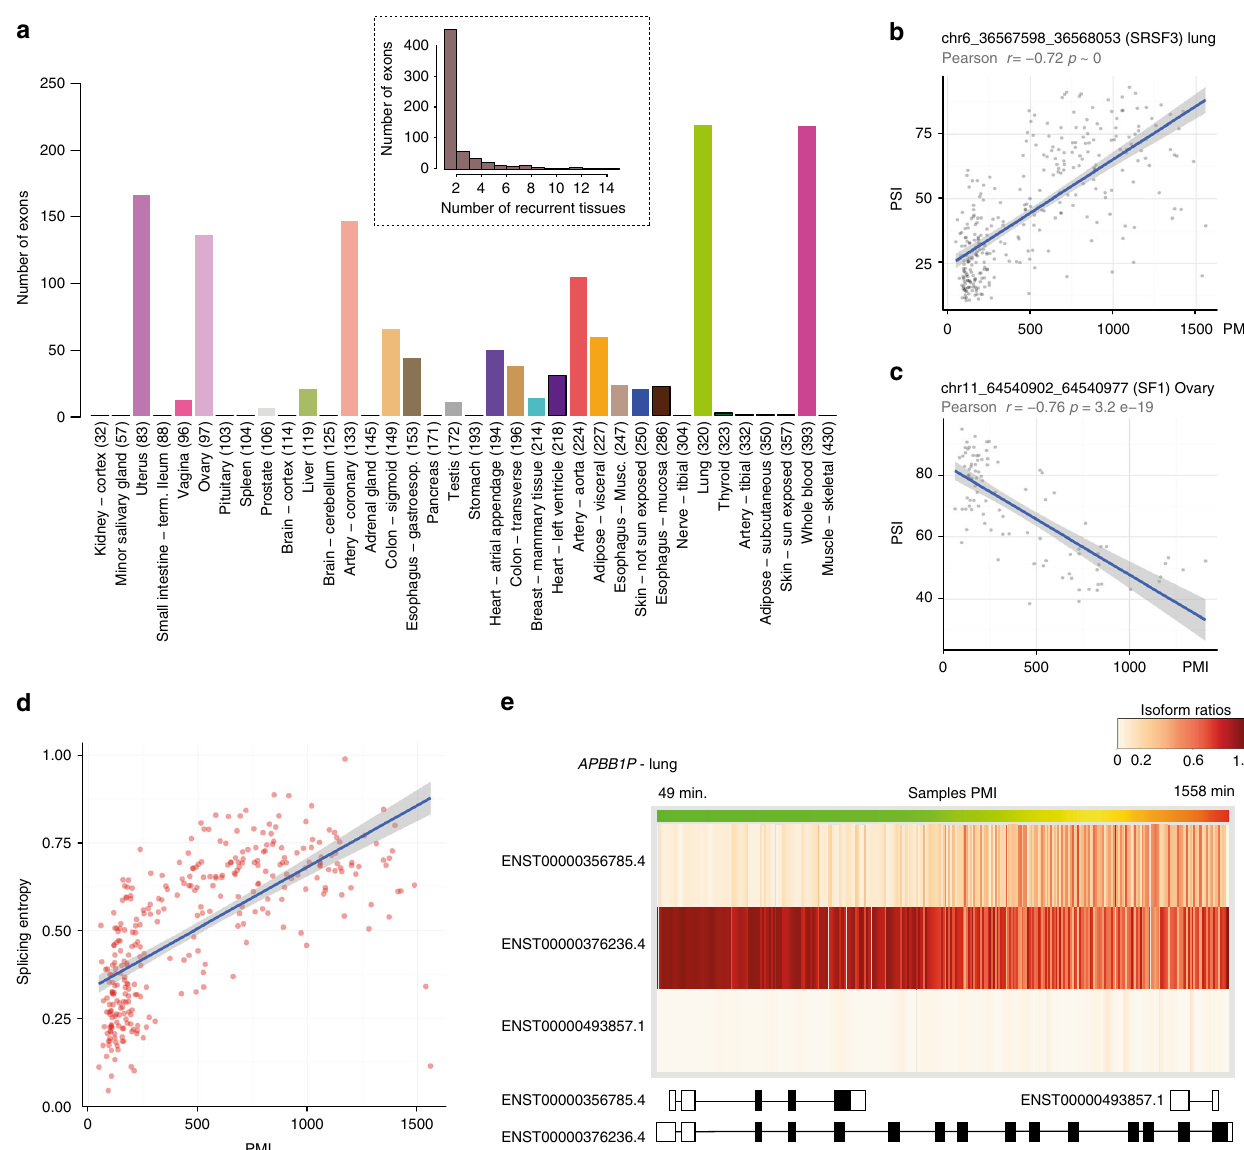
Fig. 5 Effect of PMI on splicing. a Distribution of the number of exons with signi fi cant differential inclusion across the different tissues; inset: number of exons with differential inclusion occurring in multiple tissues. b , c Examples of two exons with PMI-correlated inclusion levels. SRSF3 and SF1 encode pre- mRNA splicing factors that form part of the spliceosome. d Splicing Entropy for the APBB1IP gene depending PMI in the lung tissue. e APBB1IP gene has three isoforms. The heatmap shows the proportion of each isoform in the Lung samples sorted by PMI (1 indicates that only one isoform contributes to the expression of the gene and 0 that the isoform is not expressed) PMI of the samples range from 49 to 1558 minand are represented in the green to red gradient scale bar. Exon structure (not to scale) for the three isoforms is represented below. This fi gure depicts how the expression of the longer transcript in this gene becomes less dominant as PMI increases, and, as a consequence, the abundance of the different isoforms tends to